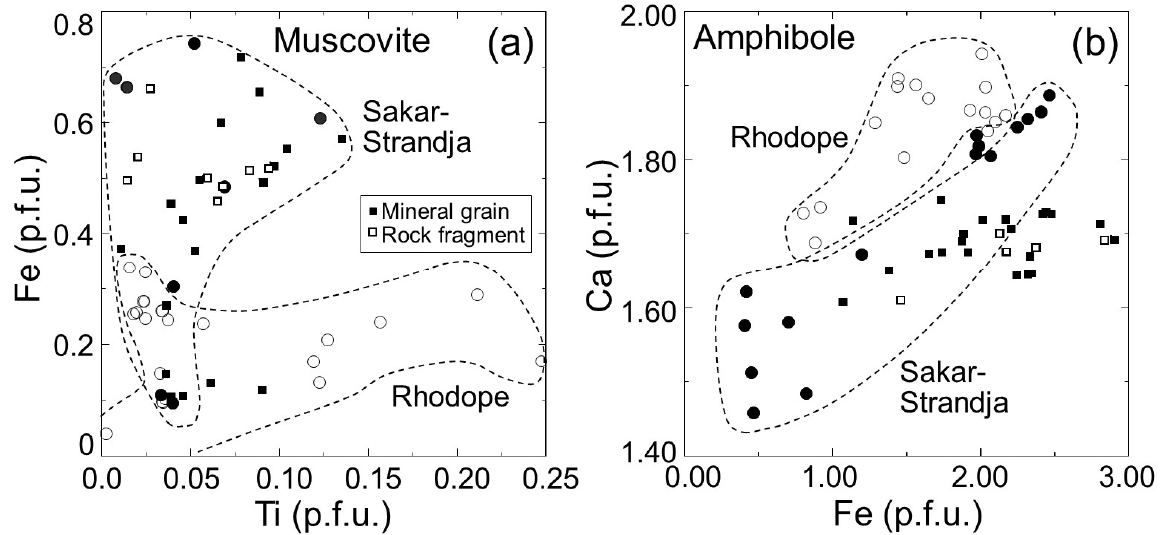
Figure 7. ( a , b ) Correlations of cations per formula unit (pfu) of minerals in mineral grains and rock fragments from pottery samples and metamorphic and igneous rocks from the Eastern Rhodope massif and Sakar–Strandja Mountains. ( a ) Ti vs. Fe in muscovite. Open circles, muscovite in gneiss and pelitic schists from the Eastern Rhodope massif [27,29,31]; solid circles, muscovite in gneiss and pelitic schists from the Sakar–Strandja Mountains [19,21]; closed squares, muscovite as mineral grains; solid squares, muscovite in rock fragments. ( b ) Fe vs. Ca in amphibole. Open circles, amphibole in schist, amphibolite, metamorphosed gabbro, and gabbro from the Eastern Rhodope massif [29,30,33,36]; solid circles, amphibole in amphibolite, metagranitoids, and gabbro from the Sakar–Strandja Mountains [19,46]; closed squares, amphibole as mineral grains; solid square, amphibole in rock fragments.